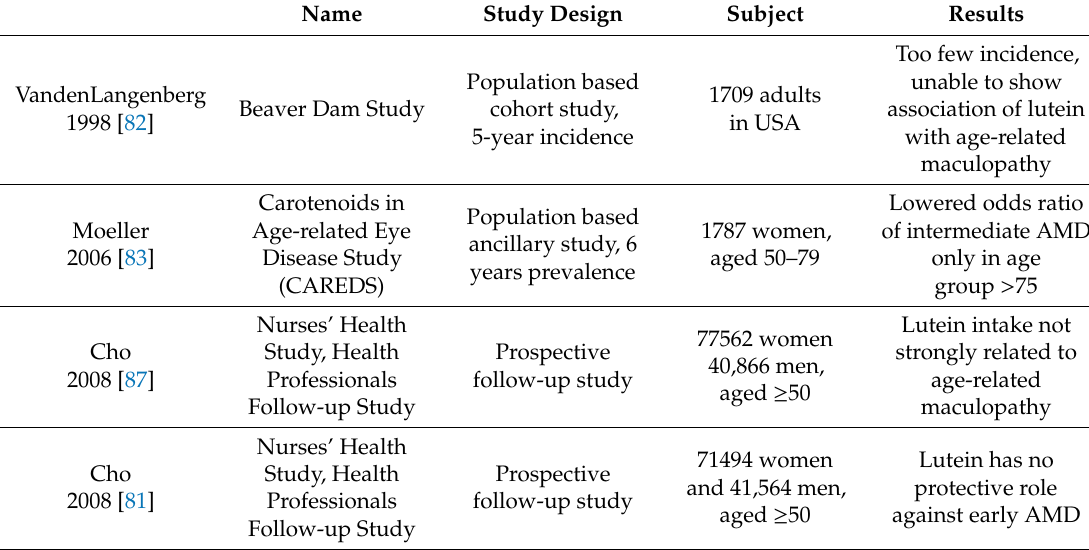
Table 5. Studies showing no association between lutein and AMD